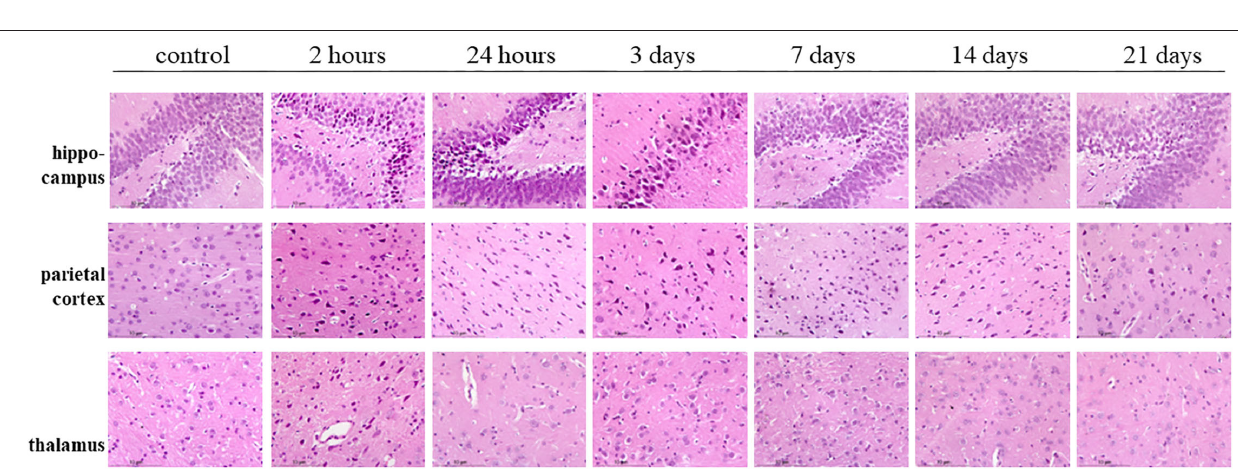
FIGURE 7 | Correlations between the cumulative time from the Morris water maze and the GluCEST% value after CO poisoning.